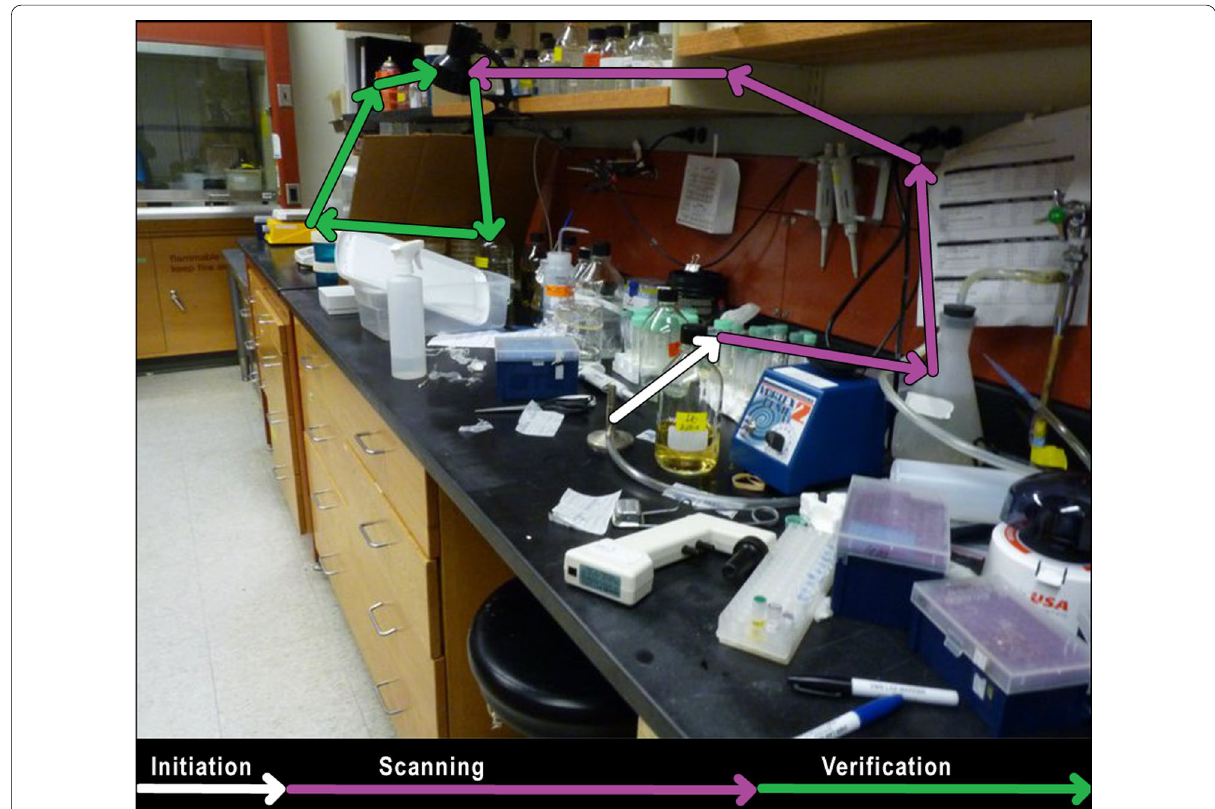
Fig. 1 An example scan path divided into search epochs. In this scene, the target is the black lamp clamped to a shelf. Initiation (white) is when the observer begins to search the scene, defined as the time between stimulus onset and the first saccade. Scanning (purple) is the search epoch, defined as the time between the first saccade and the first fixation on the target object. Verification (green) is when the observer confirms that the object they fixated is the target object, operationalized as the time between initially fixating the target object and the subject’s response. Scene image courtesy of